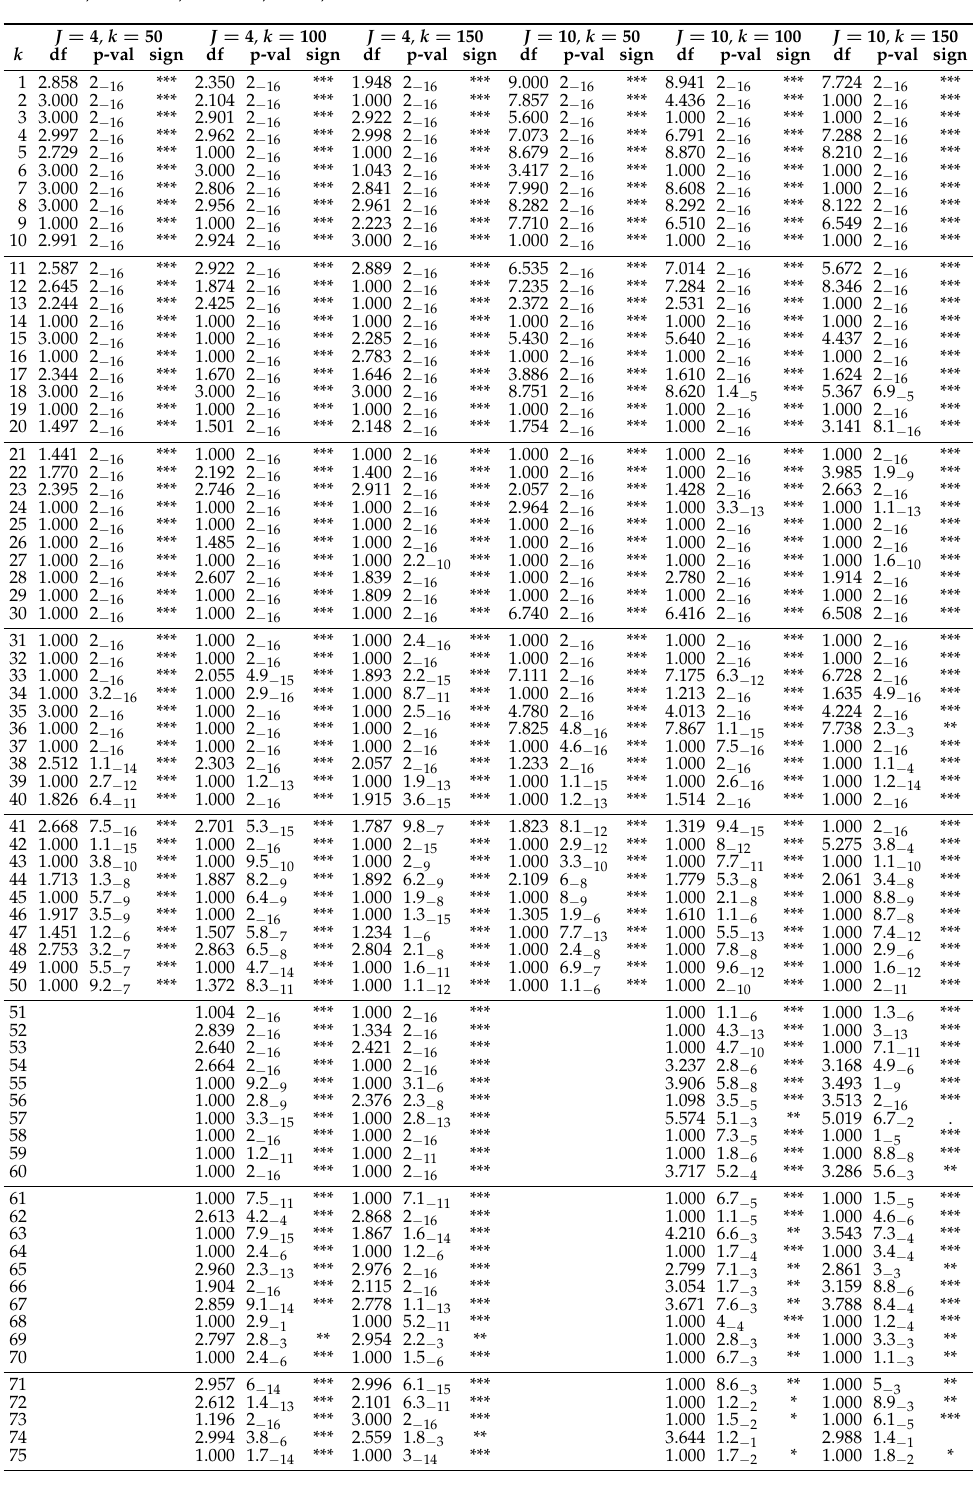
4,10 per dimension at stages ∈ { }